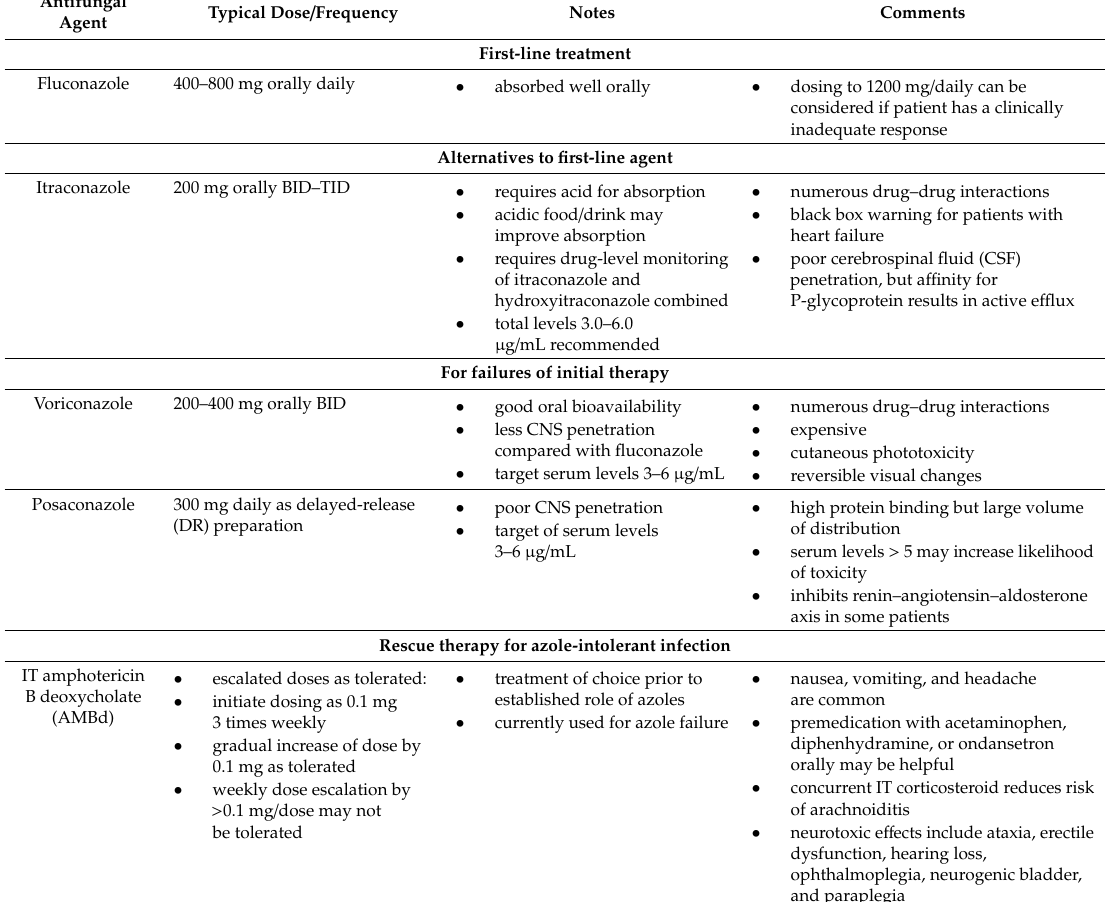
Table1. Summaryofmedicationsusedforthetreatmentofcentralnervoussystem(CNS)coccidioidomycosis. Antifungal